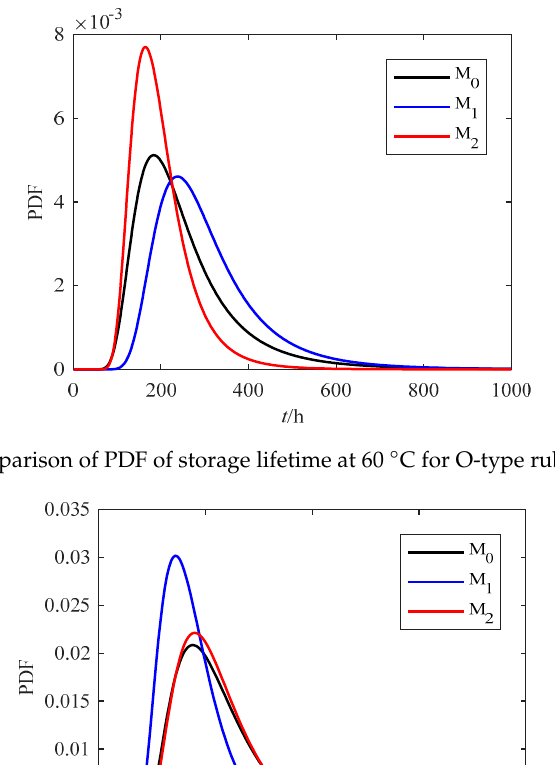
Figure 7. Comparison of PDF of storage lifetime at 50 °C for O-type rubber seal rings.